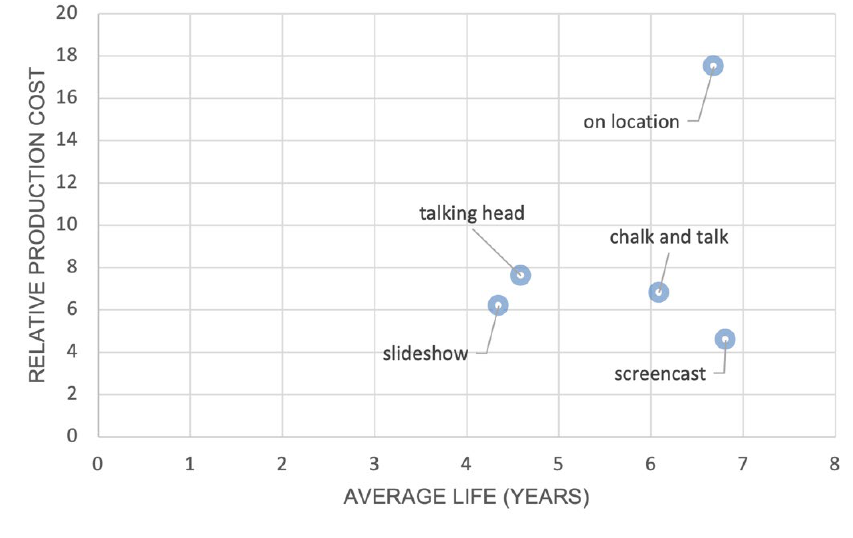
Average Life Span and Production Cost by Production